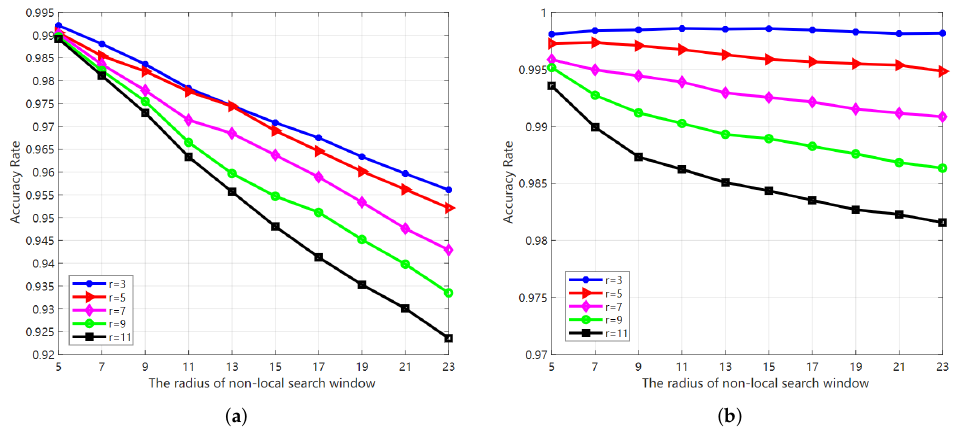
Figure 19. The SA (%) of LBNL_FCM and GLR_FCM carried out on the second simulated SAR image with different sizes of search window w × w and different sizes of local neighborhood r × r . ( a ) LBNL_FCM; ( b )